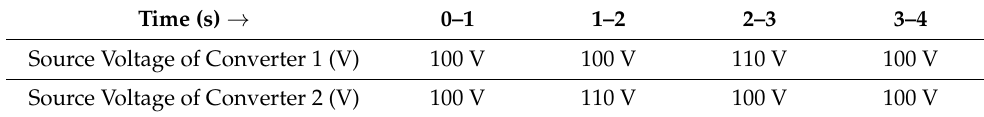
Table 5. Variation in source voltage of converters at different intervals.